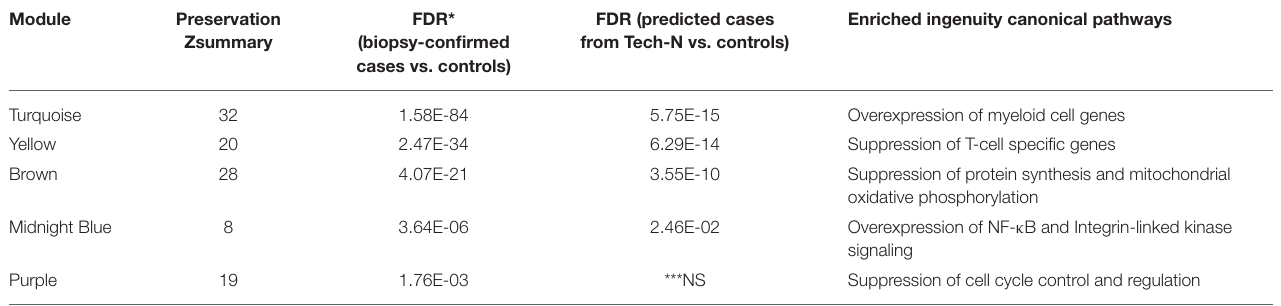
TABLE 4 | Preservation and functional annotation of significantly differentially expressed modules between cases and controls by Gene Set Enrichment Analysis (GSEA). Module